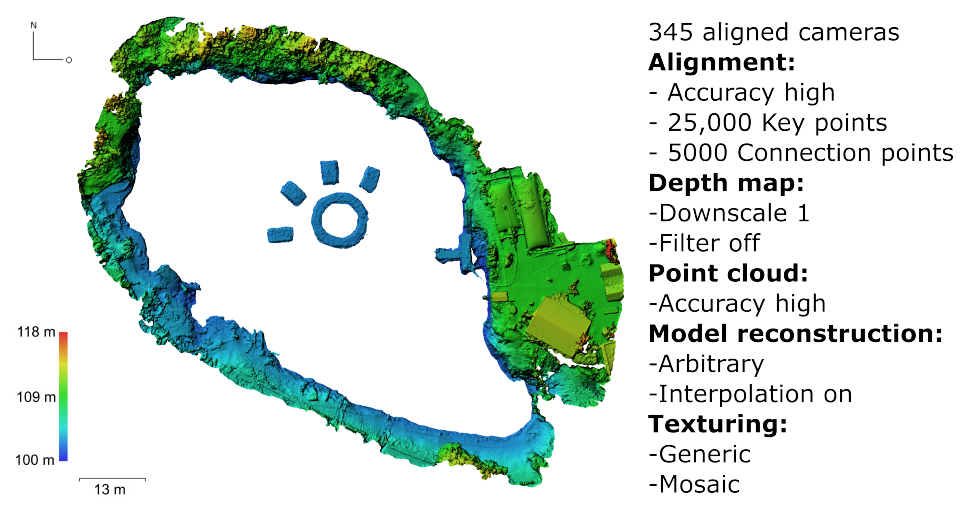
Figure 9. Results of the reconstructed landscape and the reconstruction parameter of the Agisoft Metashape [38] as the digital height model of the drone images manually cleaned.